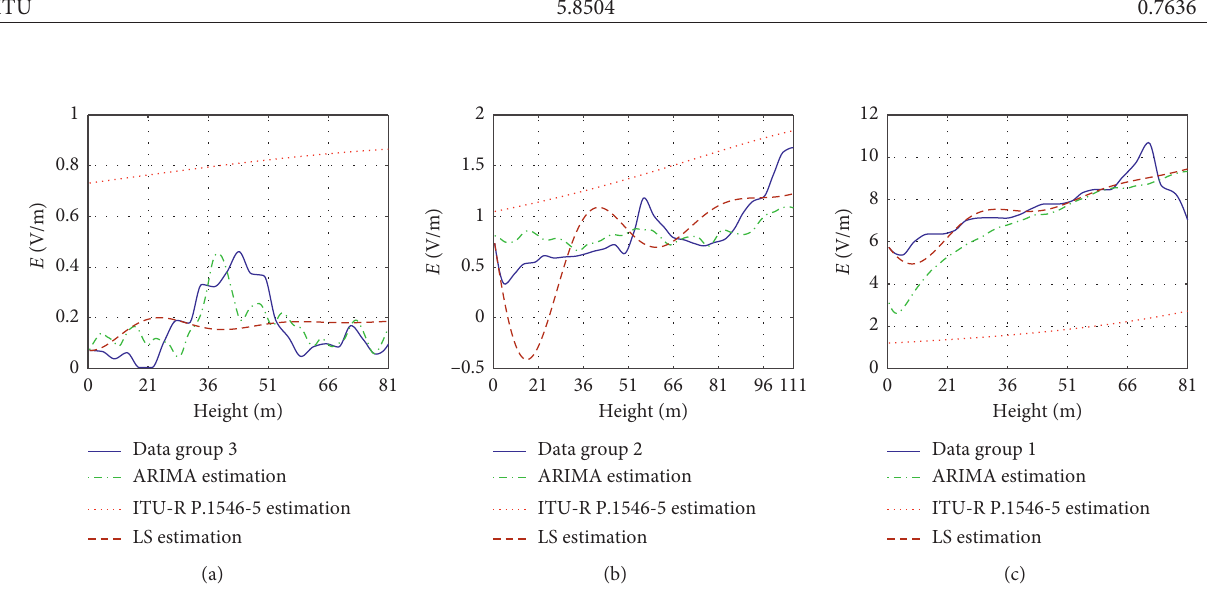
Figure 14: ARIMA estimation for (a) “data3” with tendency reintegrated ( 􏽢􏽥 L with tendency reintegrated (